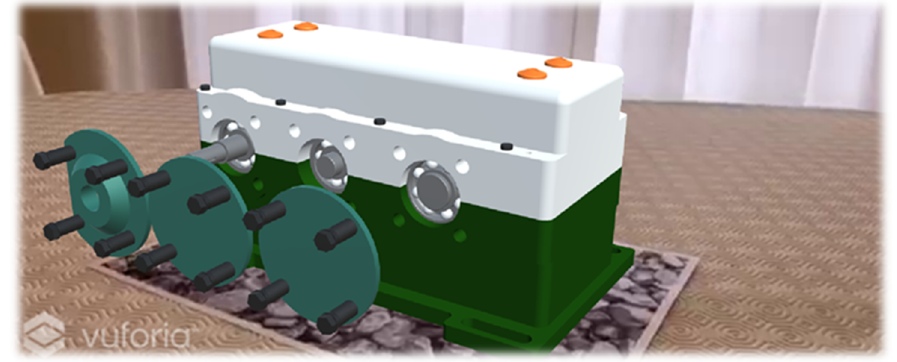
Figure 16. Animation of the Gearbox in AR.